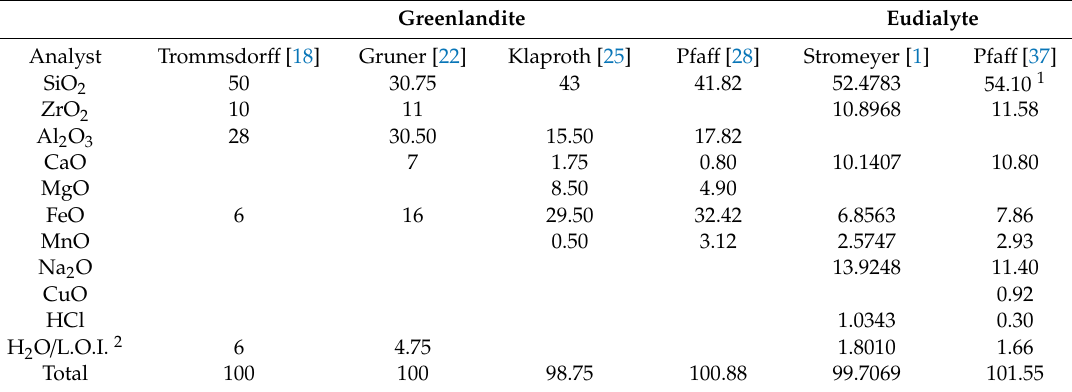
Table 1. Compiled chemical analyses of greenlandite and eudialyte by various analysts.